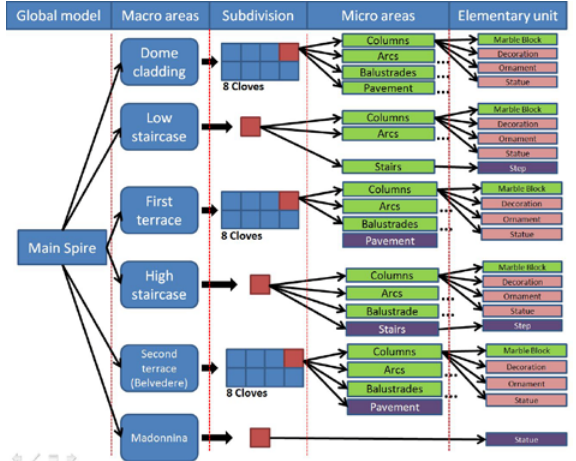
Figure 6: Summary diagram of the subdivision of the spire to compute a structured modeling process. In green the elements modelled photogrammetrically using an image modelling approach. In violet those modelled with a laser scanner and pink the parts reconstructed with a image matching